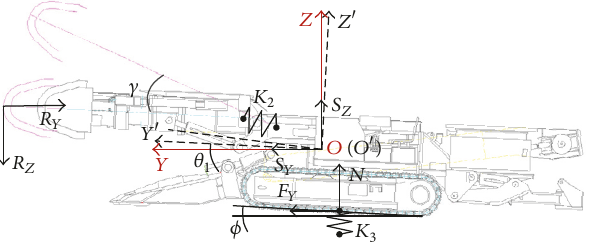
Figure 2: The coordinate system in left view of the overall